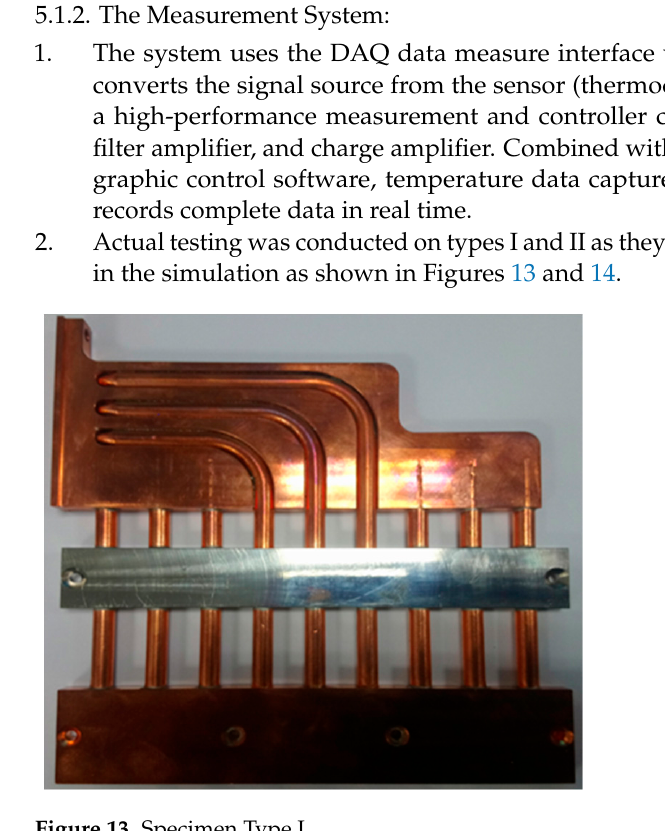
Figure 13. Specimen Type I. Figure 14. Specimen Type II. Figure 15. Measurement configuration diagram. Figure 16. Measurement configuration diagram.